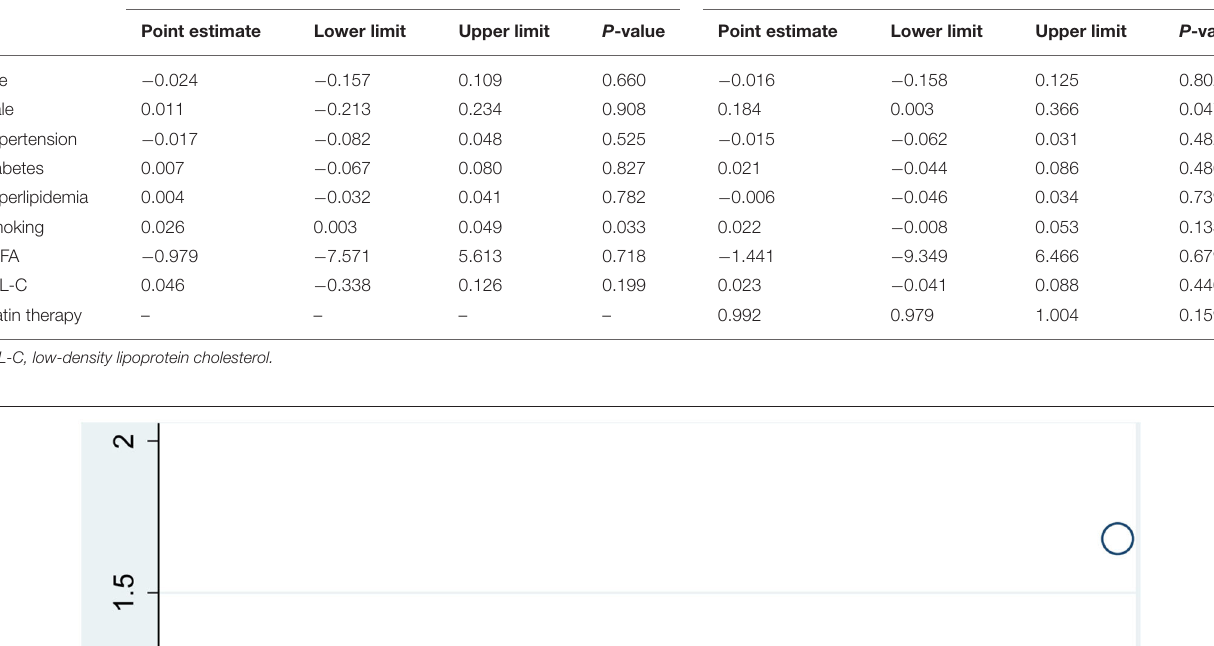
TABLE 4 | Meta-regression of influence factors for plaque rupture and macrophage accumulation in healed plaque among overall population. Plaque rupture